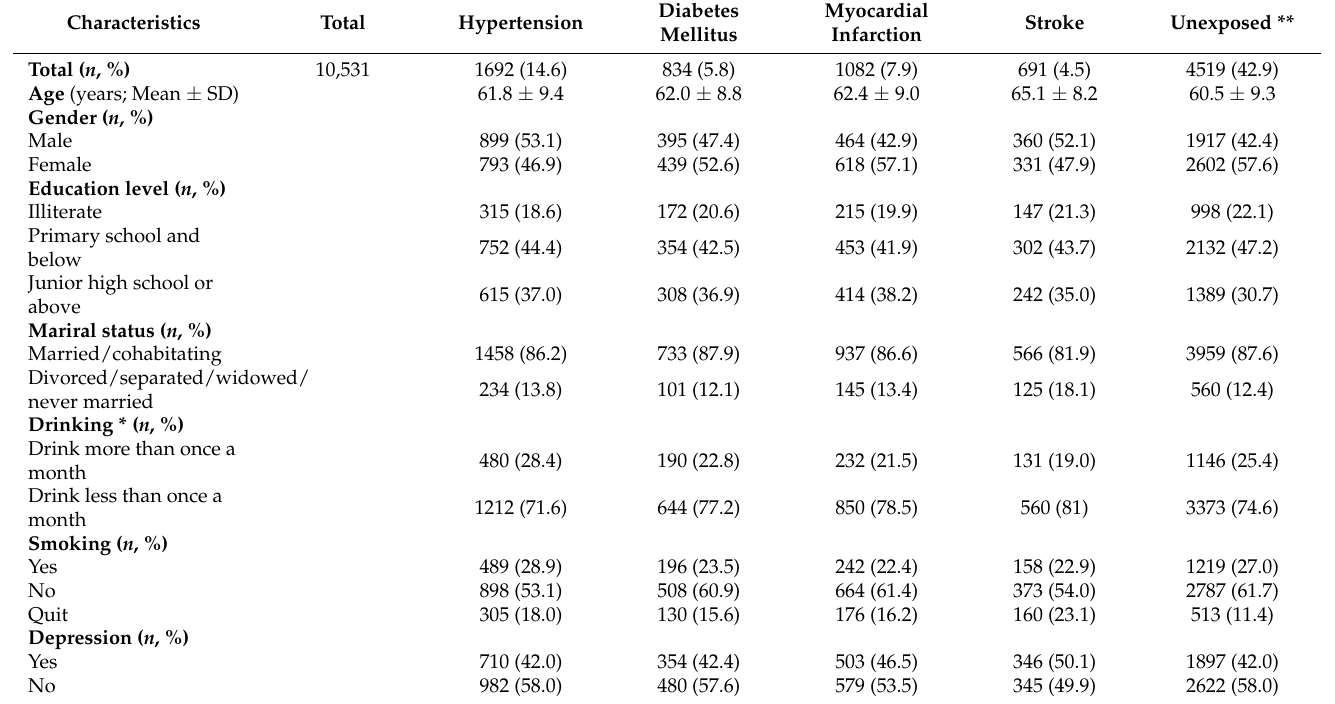
Table 1. Sociodemographic characteristics according to vascular disease status.